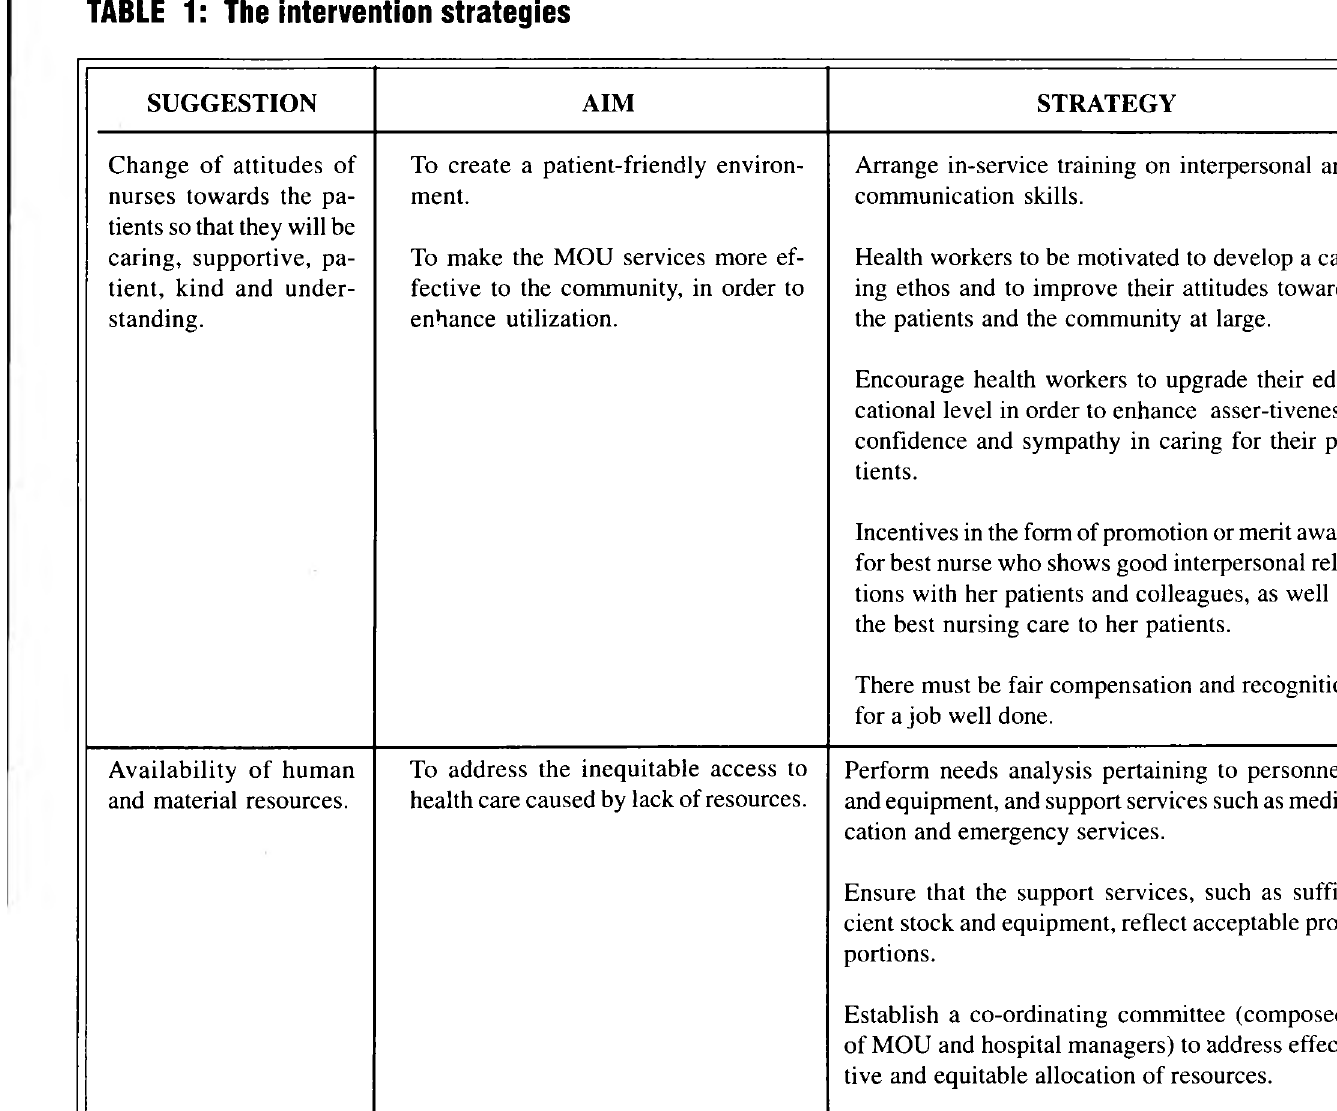
TABLE 1 : The intervention strategies SUGGESTION AIM STRATEGY Change of attitudes